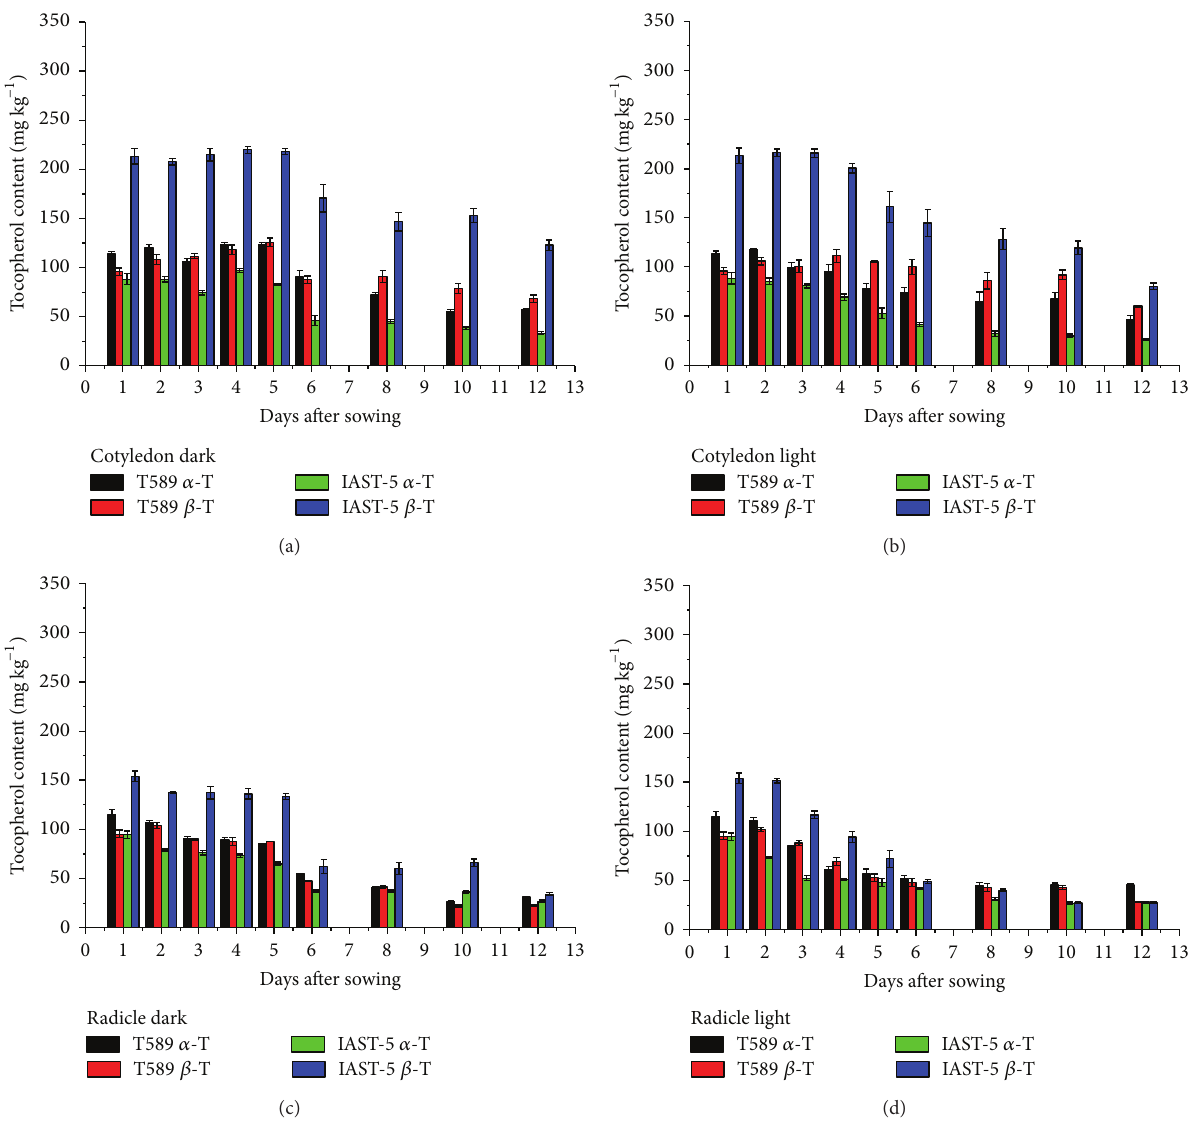
Figure 3: 𝛼 - and 𝛽 -tocopherol contents (mgkg −1 dry tissue) from 1 to 12 days after sowing in cotyledons and radicles of sunflower lines T589 and IAST-5, with different increased levels of 𝛽 -tocopherol, from seedlings grown under dark and light conditions. Data are presented as mean ± standard error of three